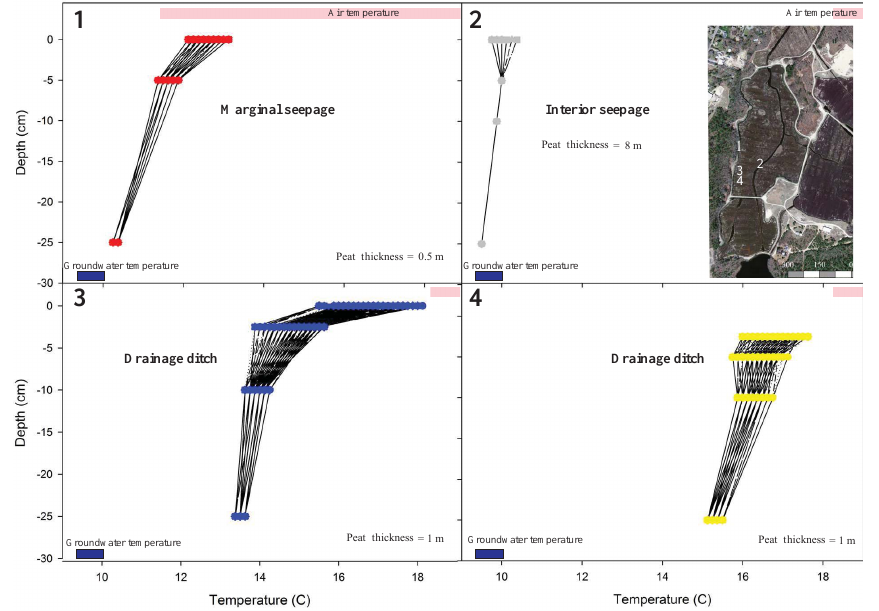
Figure 7. Temperature profiles vs. depth at Tidmarsh Farms recorded in 30–31 July 2013. For each profile, the range of air temperatures and groundwater (GW) temperatures are shown as bands of pink (air) and dark blue (GW). Locations 1 and 2 (profiles 1 and 2) show the influence of upwelling GW, expressed as type 1 preferential flow-path (PFP) seepage (profile 2) and type 2 matrix seepage (profile 1). The convex upward shape of temperature–depth profiles 3 and 4 is also consistent with upwelling GW.